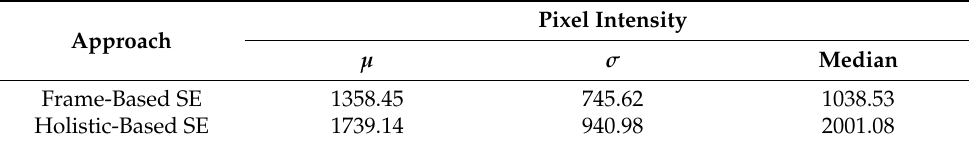
Table 4. Statistical properties of the encrypted images (average of the given dataset).